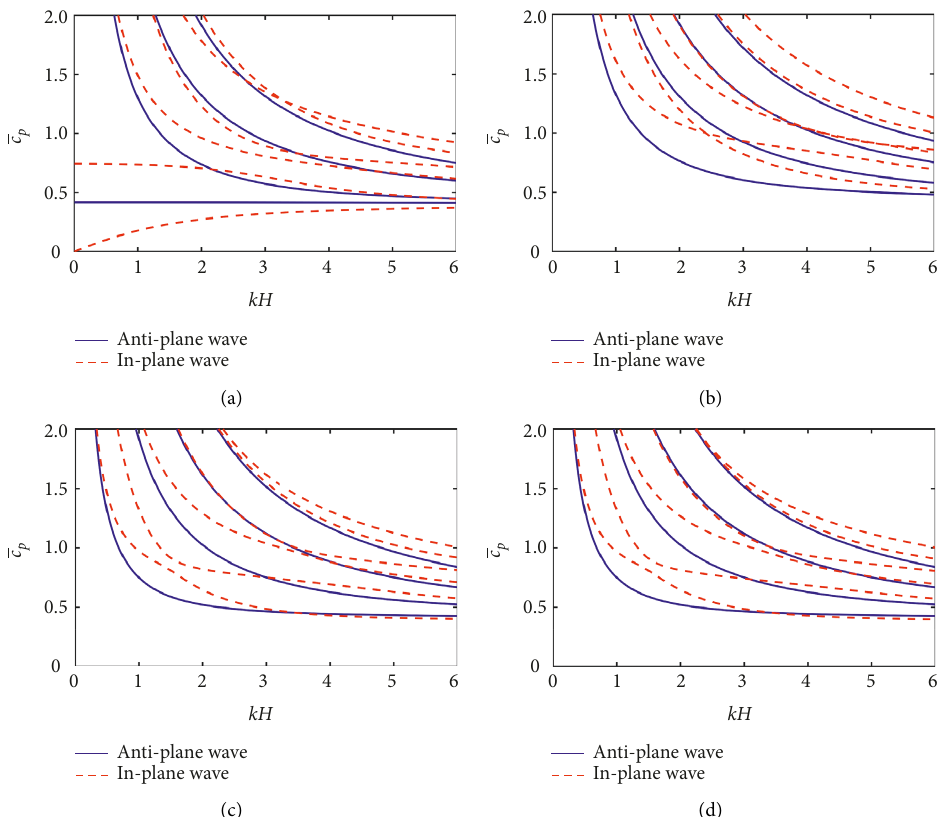
Figure 3: Dispersion curves of guided waves in the B/F/B plate with the boundaries of (a) FOO-FOO, (b) COO-COO, (c) CSS-FOO, and (d)